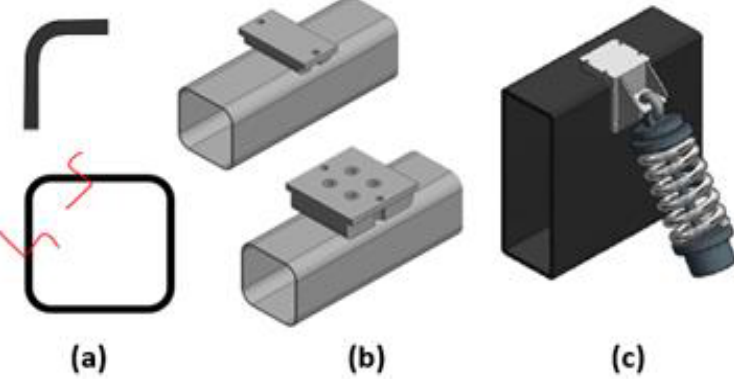
Figure 1. Representation of the experimental program: ( a ) initial analysis of the corner of the beam, ( b ) analysis of the beam component simulating a possible usage in ( c ) the frame of a vehicle.